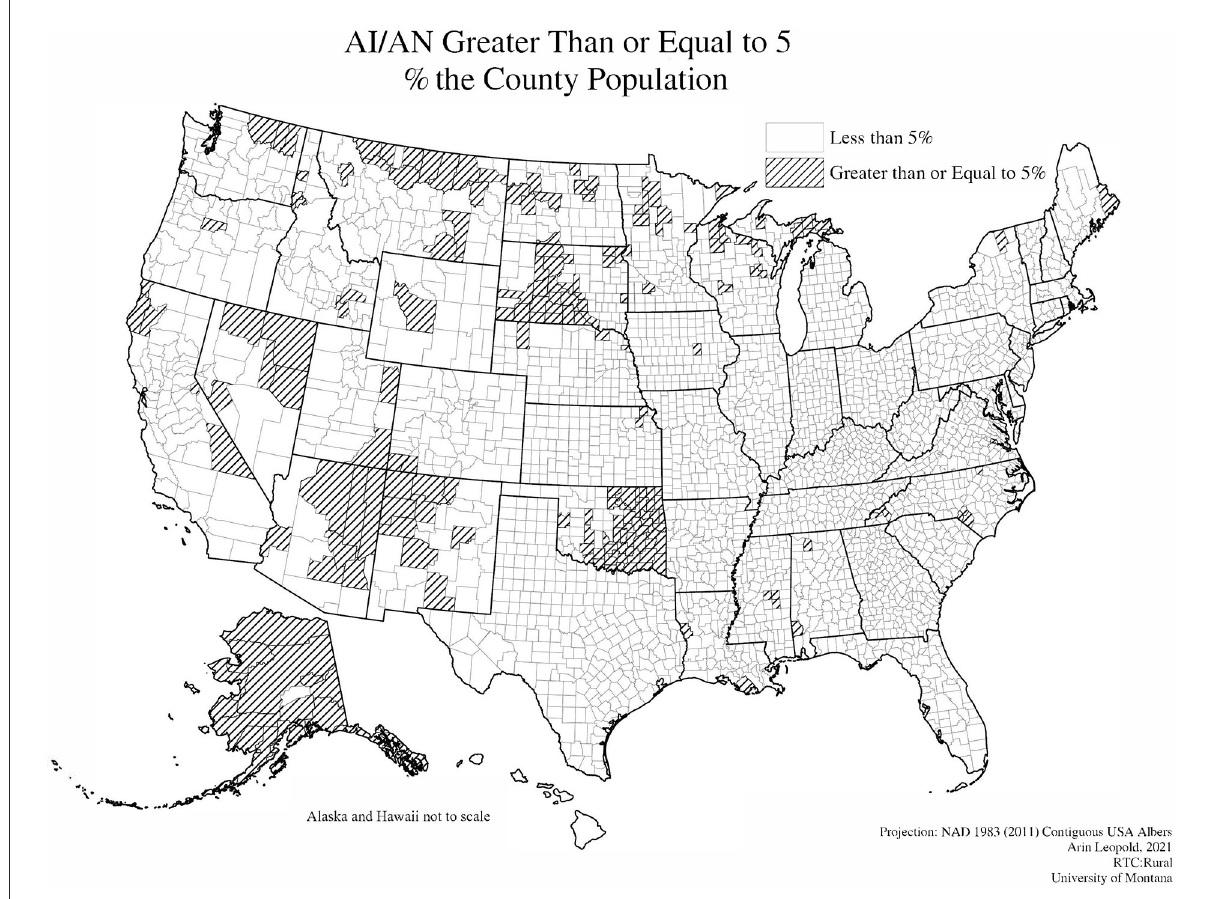
FIGURE2 Map of high AI/AN